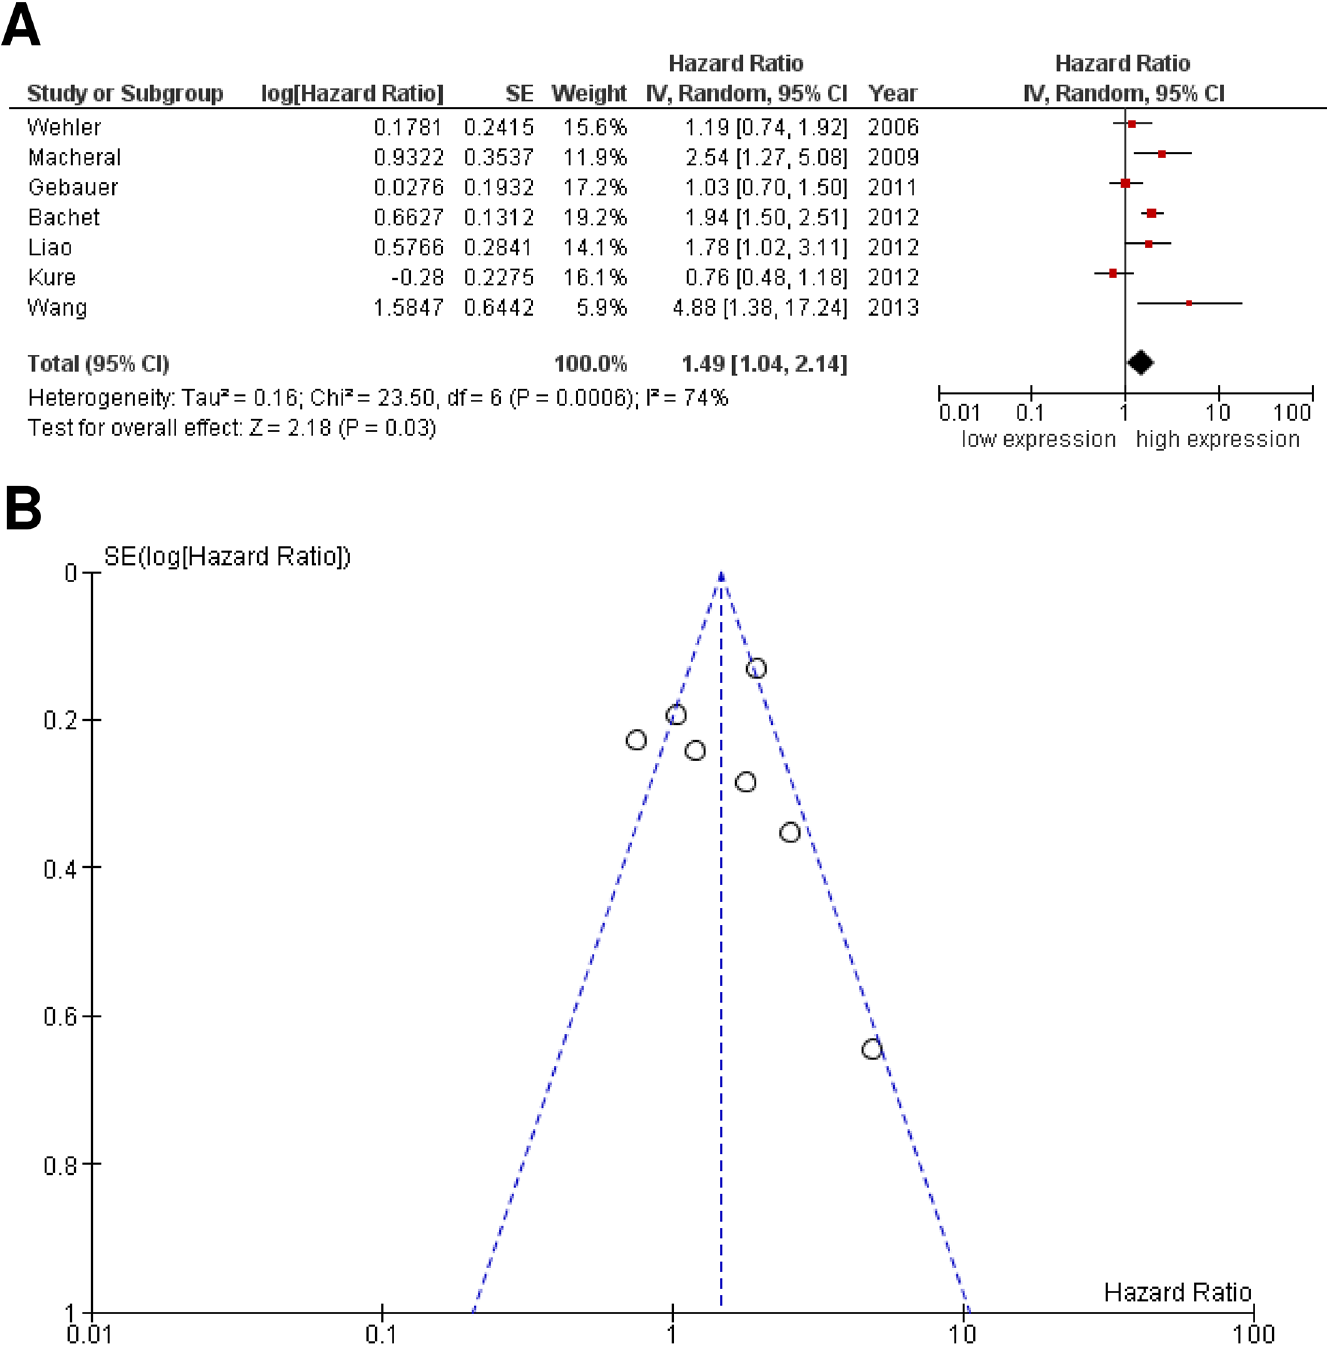
Fig 2. Meta-analysis comparing expression of CXCR4 with overall survival in patients with PDAC. (A) The Forest plot reflects the individual and pooled HR with CI. Heterogeneity was calculated by the Cochrane Q test (Chi-squared test; Chi 2 ) and inconsistency (I 2 ). (B) Funnel plot of included studies exhibited a symmetric distribution. Y-axis represents the standard error (SE), x-axis represents the study's result.